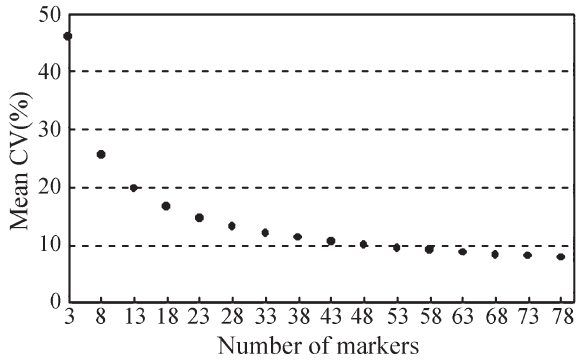
Figure 2 - Mean coefficient of variation of the genetic similarity coeffi- cients among 317 soybean cultivars, according to the number of re- sampled AFLP loci, using the bootstrap technique.